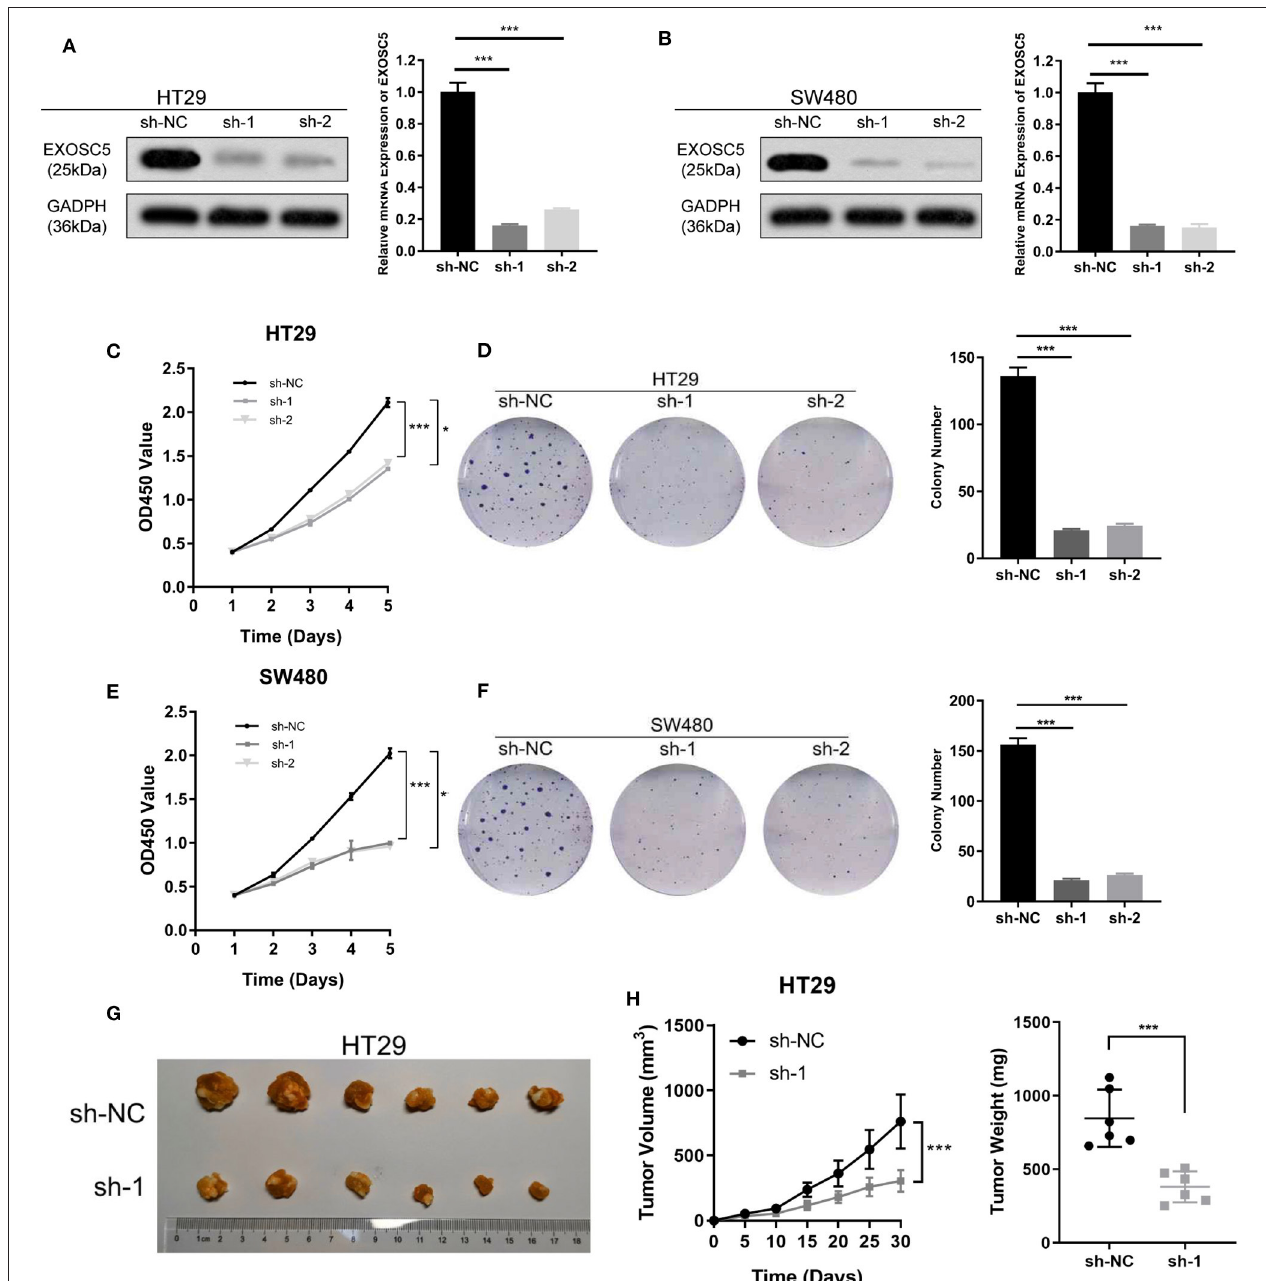
FIGURE 2 | Knockdown of EXOSC5 suppressed the proliferation and tumorigenesis of human CRC cells in vivo and in vitro . (A,B) The efficiency of EXOSC5 knockdown in HT29 and SW480 cells were determined by Western blot, GAPDH was used as a loading control. (C–F) Knockdown of EXOSC5 repressed cell proliferation by CCK-8 assays and colony formation assays. (G) Tumorigenesis assay by subcutaneous injection of HT29/sh-NC and HT29/sh-EXOSC5 cells in nude mice ( n = 6/group). (H) Tumor volumes were measured by growth curve every 5 days, and weights were measured on the terminal days. The results are presented as the mean ± SD. (* P < 0.05, *** P < 0.001).